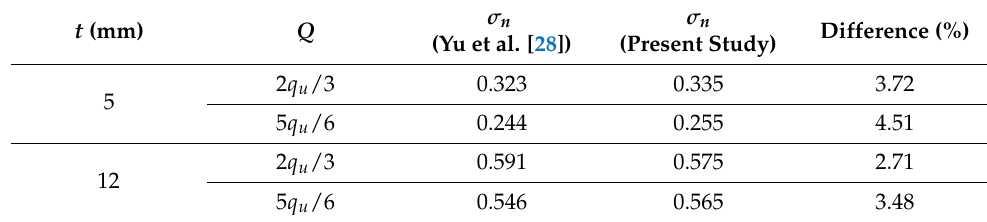
Table 8. Model verification according to